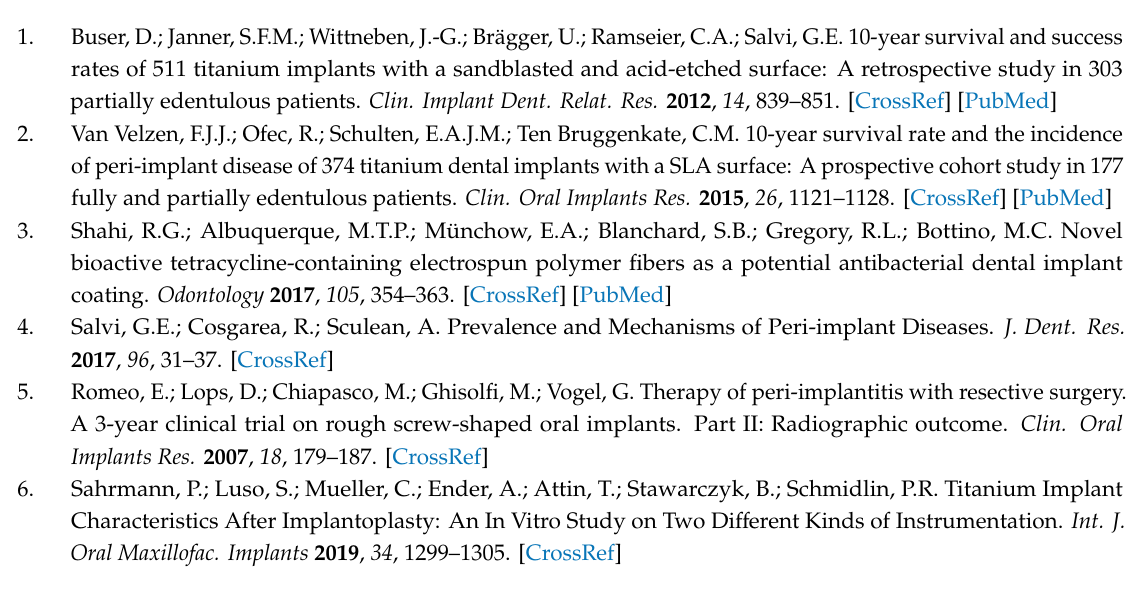
Figure S1: DSC curves of electrospun PLGA / PLC (60:40) membrane without CHX, and with CHX in presence or not of CD; Figure S2: FTIR analysis of CHX before and after G -irradiation sterilization; Figure S3: stress at break according to the loading of CHX before and after sterilization for PLGA / PLC (60:40) membrane; Figure S4: SEM images of the histological samples: 60:40%-PLGA / PLC membrane (top) and PLGA / PLC / CHX-CD (60:40:4) membrane (bottom). The circles identify the cells in the